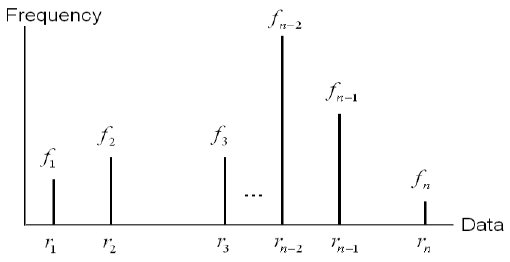
Figure 1. A typical histogram that is drawn by the first strategy [2]. Since the histograms based on this strategy are discrete, calculation of the LPM in its continuous form of (6) is not possible and the equation should be converted to its equivalent discrete one as